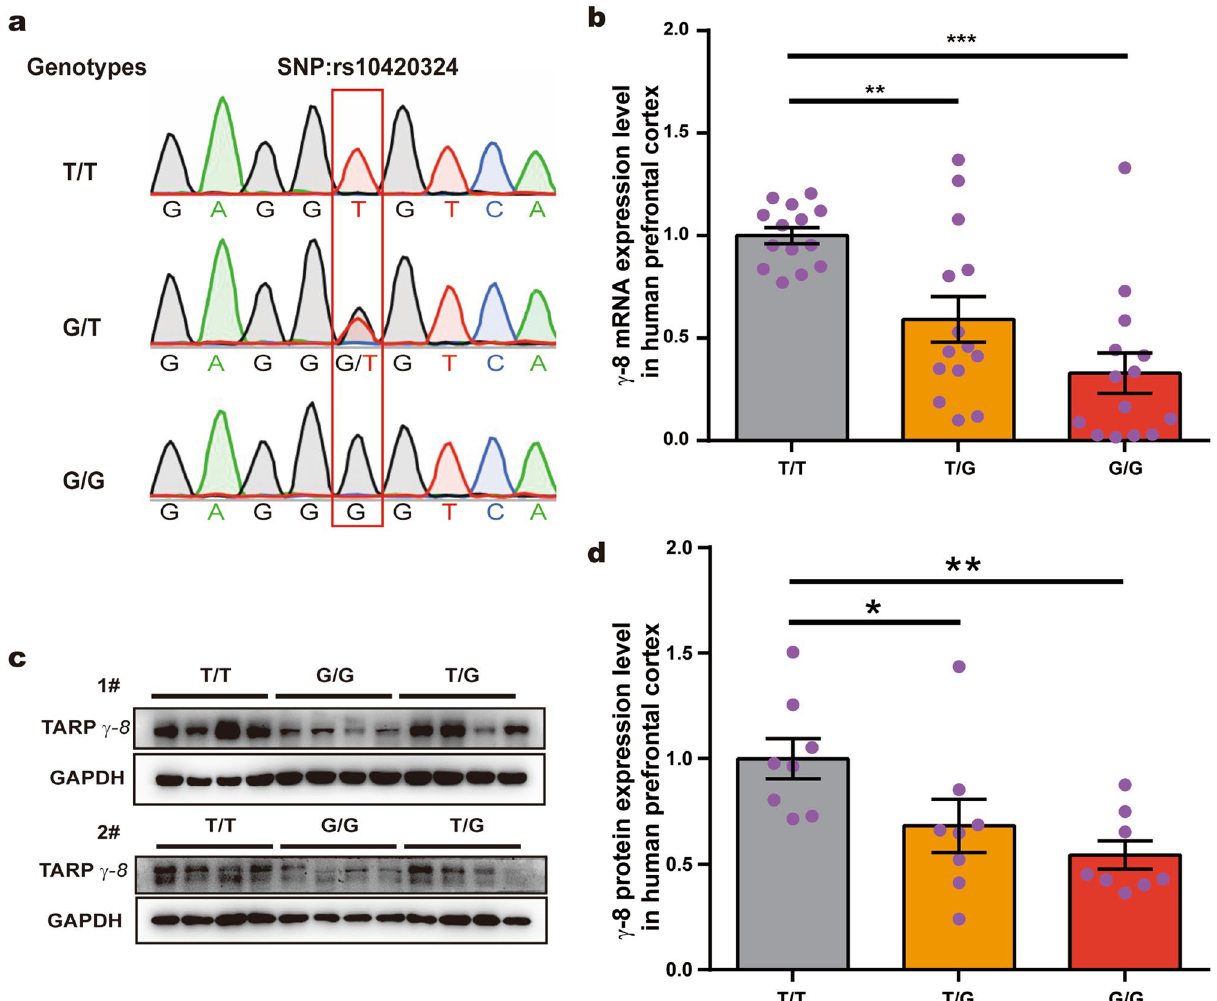
Figure 2. SNP rs10420324 determines TARP γ-8 expression in human brains. ( a ) Sanger sequencing results showing the T/T, G/T, and G/G genotypes at the CACNG8 rs10420324 locus in human prefrontal cortex tissues (outlined with a red box). 101 human prefrontal cortex tissues of male adults (25–45 years old) were obtained from a Chinese brain bank in Wuhan. ( b ) Fold change in the TARP γ-8 mRNA expression level in the human prefrontal cortex tissues with different rs10420324 genotypes (n = 14 for each). TARP γ-8 mRNA expression was normalized using β-actin mRNA. ( c ) Western blot analysis of the TARP γ-8 proteins in human prefrontal cortex tissues with different rs10420324 genotypes (n = 8 for each genotype). GAPDH was an internal reference. ( d ) Quantification of the TARP γ-8 protein expression levels in ( c ). TARP γ-8 expression was normalized using GAPDH. Data represent the mean ± s.e.m. one-way ANOVA, * p < 0.05, ** p < 0.01, *** p <